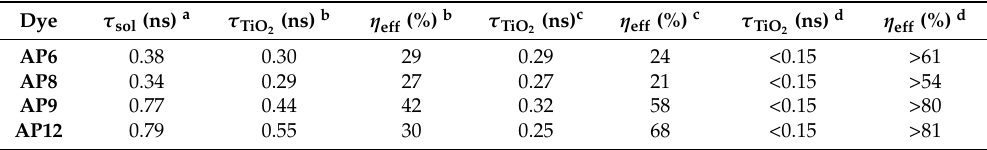
Table 3. Fluorescence lifetime and charge injection efficiencies of AP6 , AP8 , AP9 , and AP12 in different environments.